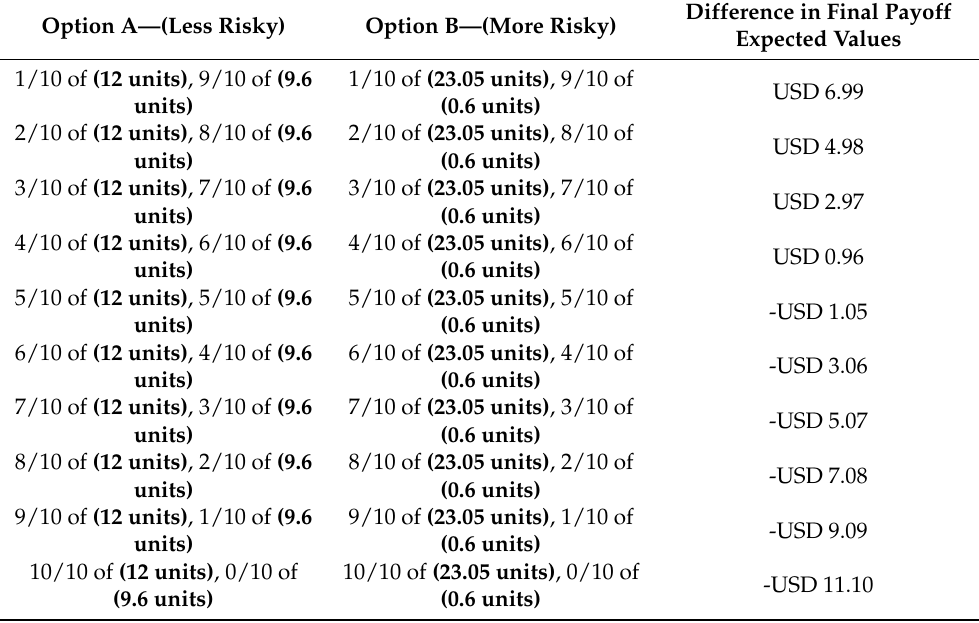
Table A2. Rationally equivalent widget-based lotteries along with their corresponding final payoff expected values.